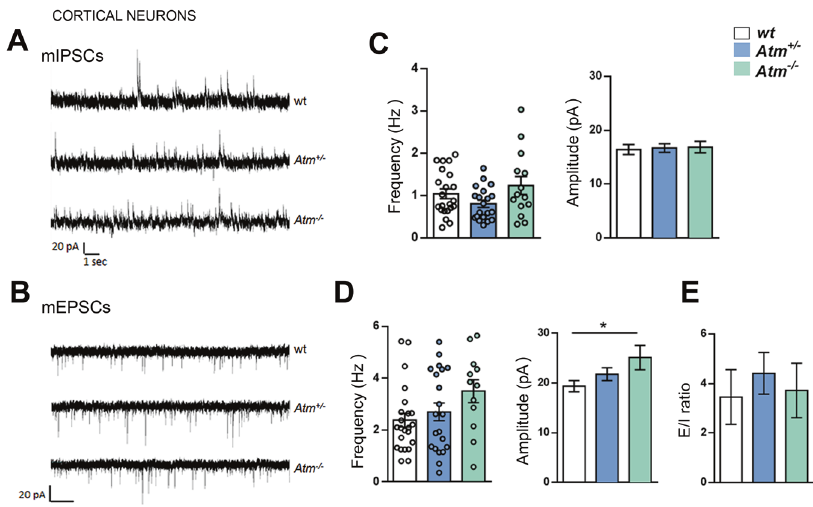
Fig. 2 ATM does not control the excitatory-to-inhibitory GABA switch in cortical neurons. A Representative traces of calcium transients in 6DIV wt and Atm − / − hippocampal neurons. B No differences in basal intracellular calcium levels are detected in wt vs Atm − / − . The number of GABA-responding neurons is reduced in Atm − / − hippocampal neurons; t test: p = 0.013. Calcium increments induced by exogenous GABA ( Δ GABA) are comparable in wt and Atm − / − . Upon KCl stimulus no variations were measured in the generated calcium fl uxes among the two groups. (Coverslips: wt = 4 vs. Atm − / − = 5; total cells: wt = 156 vs. Atm − / − = 182; independent experiments = 3. C and D KCC2 and Mecp2 protein levels are increased in the hippocampi of P40 Atm − / − mice respect to wt controls. KCC2 t test: p = 0.0005; Mecp2 t test: p = 0.0032. E Representative traces of calcium transients in 6DIV wt and Atm + / − cortical neurons. F Basal calcium levels and percentage of GABA- responding neurons are not altered in wt vs. Atm + / − , neither are calcium increments upon GABA and KCl administration. Coverslips: wt = 3 vs. Atm + / − = 3; total cells: wt = 101 vs. Atm + / − = 92; independent experiments = 3. G and H KCC2 and Mecp2 protein levels are unaltered in P40 Atm + / − cortices respect to wt. I Representative traces of calcium transients in 6DIV wt and Atm − / − cortical neurons. J Basal calcium levels and percentage of GABA-responding neurons are not altered in wt vs. Atm − / − , neither are calcium increments upon GABA and KCl administration. Coverslips: wt = 5 vs. Atm − / − = 6; total cells: wt = 220 vs. Atm − / − = 242; independent experiments = 3. K and L KCC2 and Mecp2 protein levels are unaltered in P40 Atm − / − cortices respect to wt. Numbers in bars indicate the number of animals. Bars in graphs indicate ±SEM.